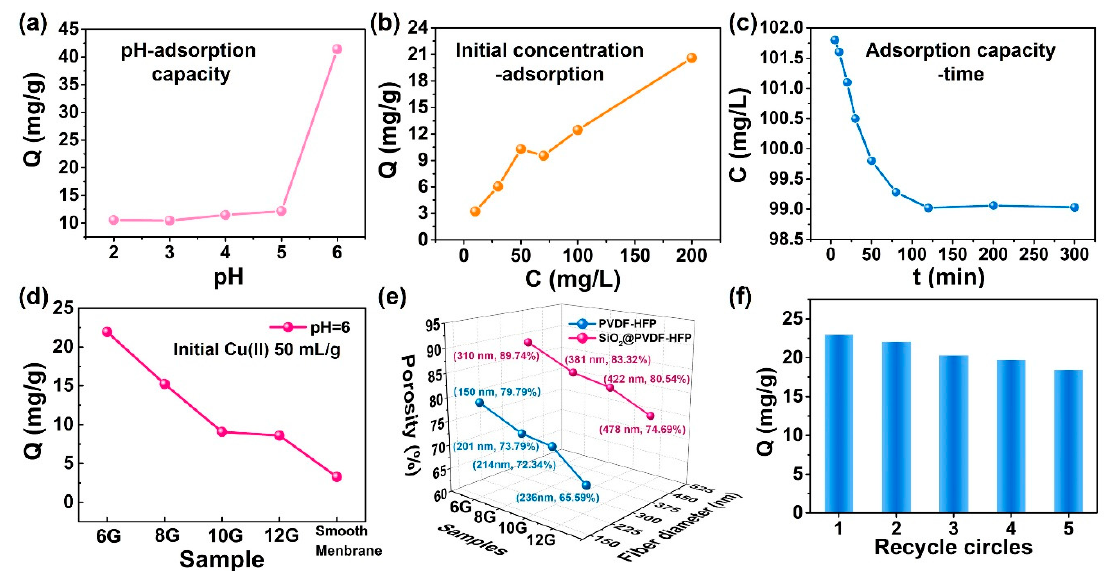
Figure 5. ( a ) The relationship between pH value and Cu(II) removal capacity. ( b ) The change of Cu(II) amount with different initial Cu(II) concentrations. ( c ) Change of the total Cu(II) in the solution with time. ( d ) The removal capacity of as-prepared SiO 2 @PVDF-HFP samples with different fiber diameters. ( e ) Relationships between fiber diameters and porosity of both PVDF-HFP and SiO 2 @PVDF-HFP electrospun nanofibrous membrane. ( f ) The recyclable properties of SiO 2 @PVDF-HFP-6G nanofibrous membrane for Cu(II) adsorption.